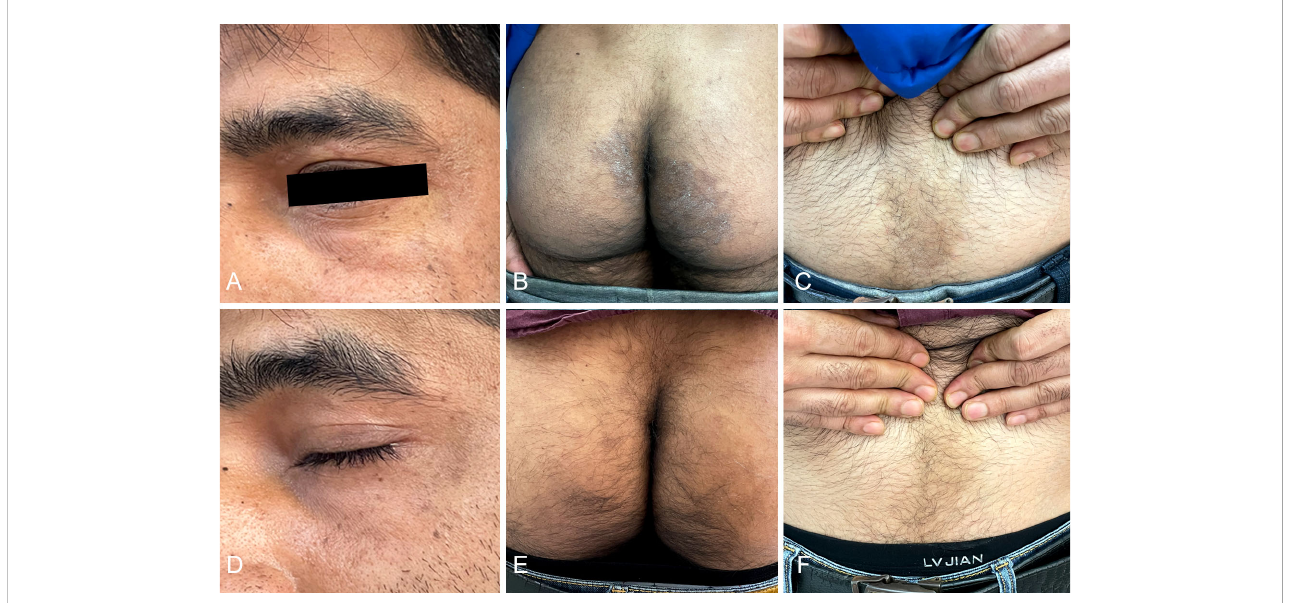
FIGURE 1 Irregular dark erythema ranging from coin to palm size with a small amount of fi ne furfur-like desquamate on the surface (A, B, C) ; Four weeks after treatment with itraconazole (D, E, F)